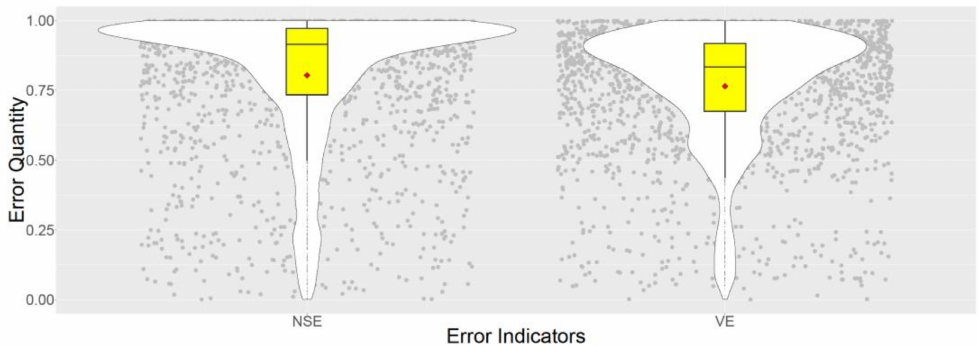
Figure 5. Distribution of emulation error indicators Nash-Sutcliffe Efficiency ( NSE ) ( left ) and Volumetric Efficiency ( VE ) ( right ) for the validation dataset. The red square shows the mean value. Each grey dot indicates a validation run